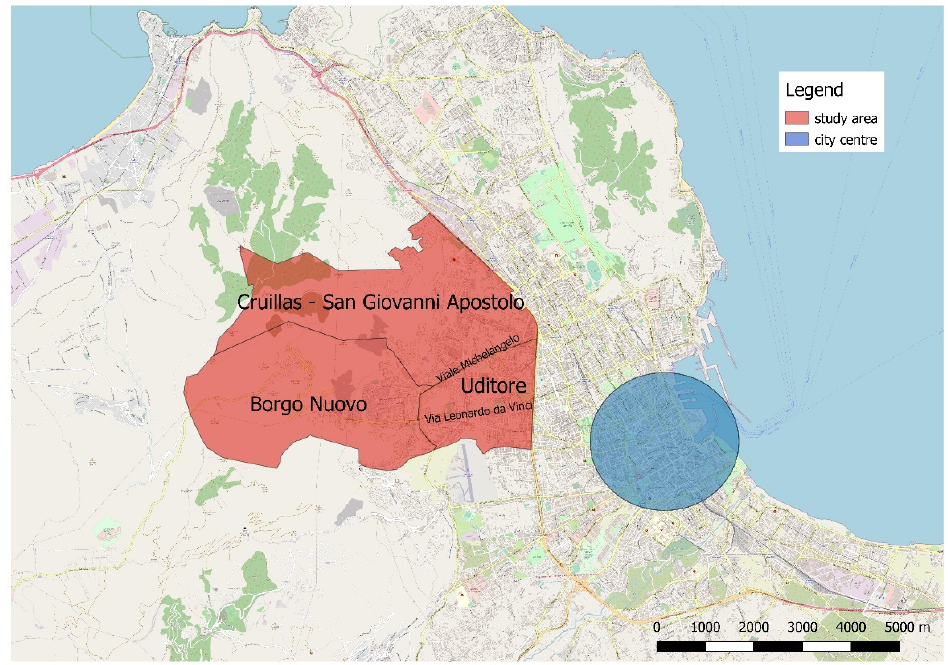
Figure 1. The neighbourhood of the city of Palermo within the study area.